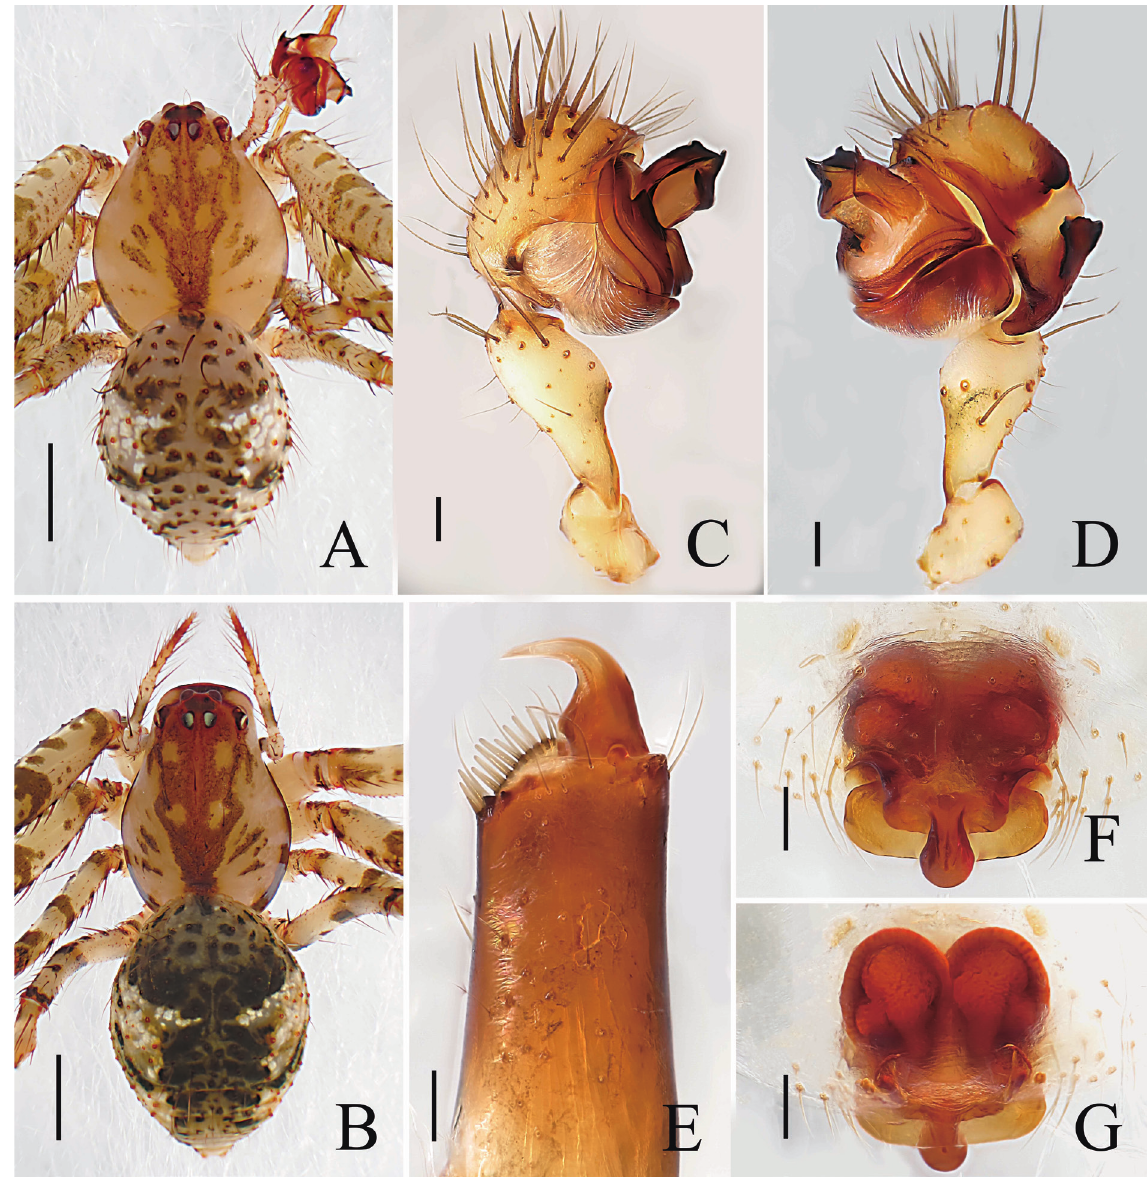
Fig. 6. Mimetus yinae sp. nov. A , C – E . Holotype, ♂ (GZ-MIM-2015-005). B , F – G . Paratype, ♀ (GZ- MIM-2017-001). A – B . Habitus, dorsal view. C . Palp, prolateral view. D . Palp, retrolateral view. E . Left chelicerae, ventral view. F . Epigyne, ventral view. G . Vulva, dorsal view. Scale bars: A–B = 1.0 mm; C–G = 0.1